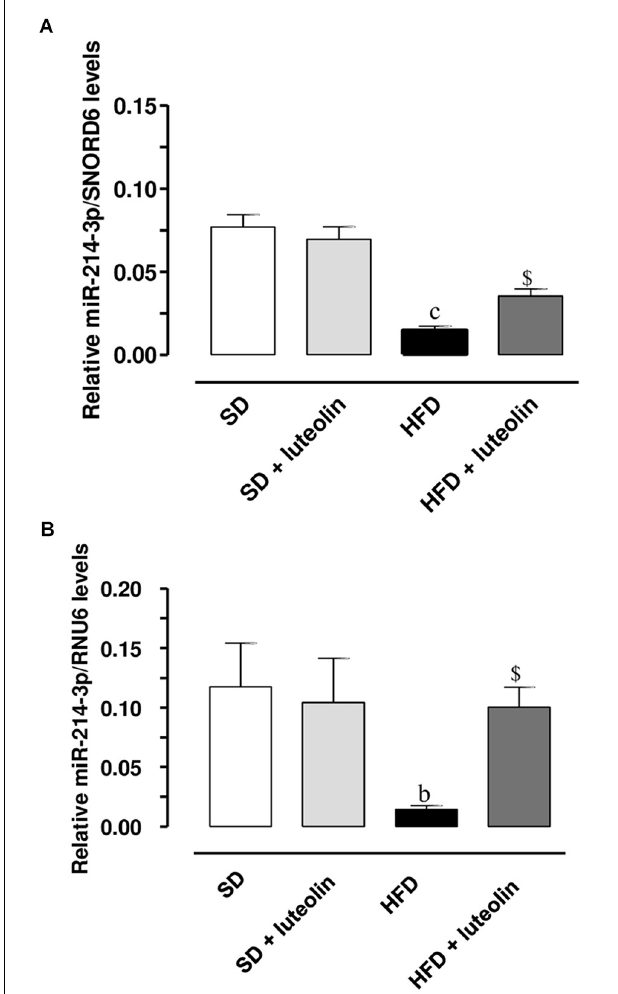
FIGURE 9 | Relative expression of miR-214-3p, normalized vs. the housekeeping genes SNORD6 (A) or RNU6 (B) , in mesenteric vessels from mice fed with SD, SD plus treatment with luteolin (10 mg/Kg/day), HFD or HFD plus treatment with luteolin (10 mg/Kg/day). Each column represents the mean ± SEM of five animals. c P < 0.001, b P < 0.01 significant difference vs. SD, $ P < 0.01 significant difference vs. HFD. Statistics: two-way analysis of variance followed by Newman–Keuls